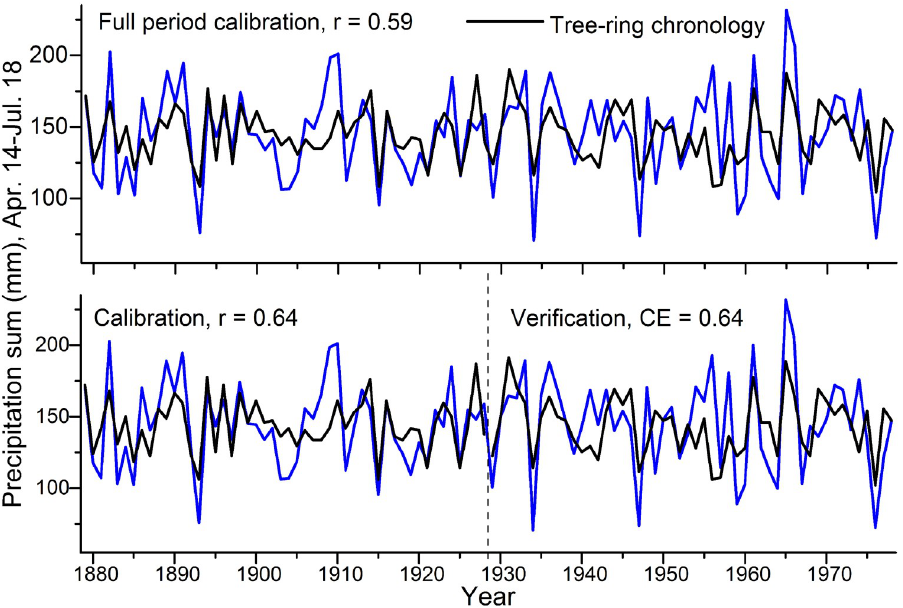
Fig 4. Results of the split period and full period calibration and verification of the climate-growth analysis.